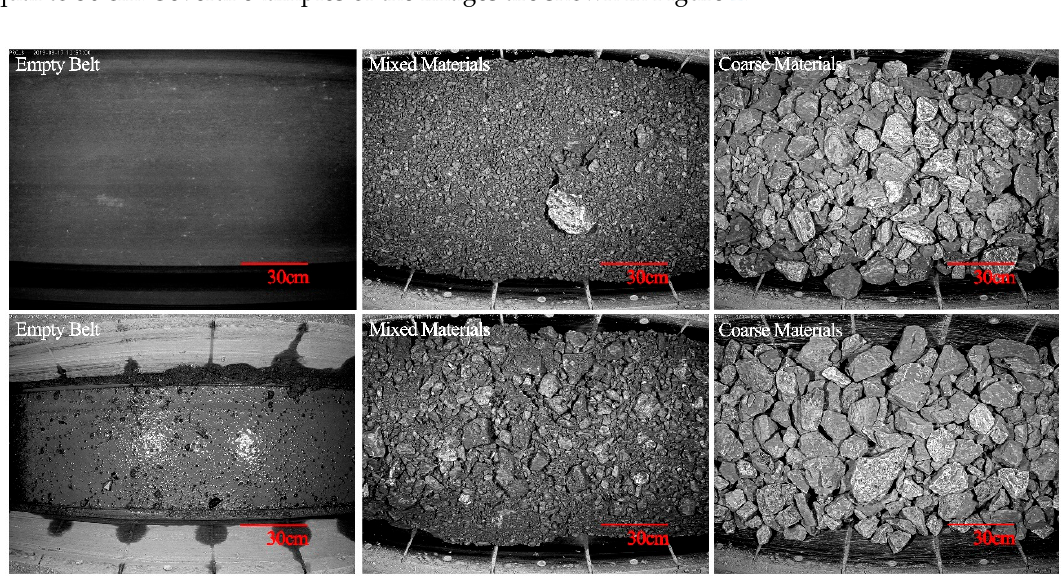
Figure 2. Samples of the original dataset: empty belt, mixed materials, and coarse materials.